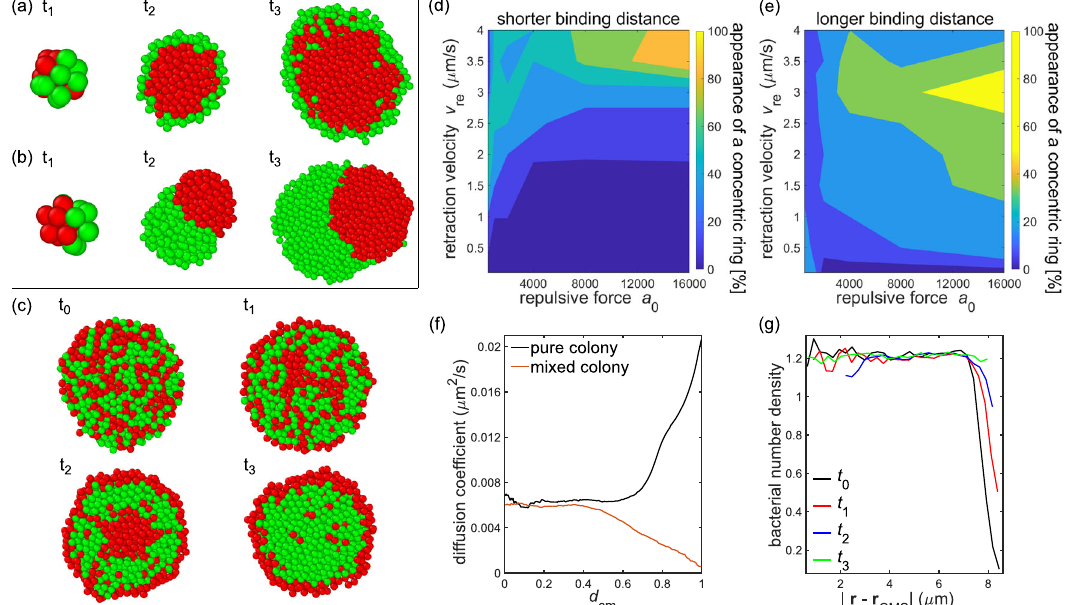
Fig. 4 Phase segregation of mixed colonies. a Simulation snapshots for three time points, t 1 − t 3 , of a growing colony consisting of cells with 14 pili (red) and cells with 7 pili (green). b Snapshots for three time points, t 1 − t 3 , of the simulated growth of a mixture of wild-type cells (WT, green) and mutants ¼ 22 : 5pN, F GD (cid:2) WT ¼ 20pN, F GD (cid:2) GD ¼ 45pN. In de fi cient in post-translational pilin glycosylation (GD, red) 32 . Pilus rupture forces are as follows: F WT (cid:2) WT rupt rupt rupt ( a ) and ( b ), Voronoi tessellation is used to locate neighbors for pilus binding. c Segregation of a binary mixture of wild-type bacteria (green) and pilus- retraction-de fi cient cells (red). Pilus-mediated interactions are long-ranged in this example with d bind = 2.5 μ m. At time t 0 , the colony is randomly mixed. Over time, the proportion of pilus-retraction-de fi cient cells increases in the colony periphery, t 1 , and wild-type cells then accumulate in a concentric sphere inside the colony, t 2 . The concentric sphere eventually disappears and wild-type cells accumulate in the colony center, t 3 . d Lifetime of the concentric sphere arrangement for short-ranged pilus interactions, d bind = 2.5 μ m. Lifetimes are given in percent of the longest observed lifetime (3000 s). e Lifetime of the concentric sphere arrangement for long-ranged pilus interactions, d bind = 3.5 μ m. Lifetimes are given in percent of 3000 s. f Diffusion coef fi cients of individual cells as a function of their distance from the colony center divided by the colony radius, d cm . Pure colonies consist of one type of cells, the mixed colony is the segregated system shown in ( c , t 3 ). g The mean radial number density of wild-type cells (green) for the simulation snapshots shown in ( c